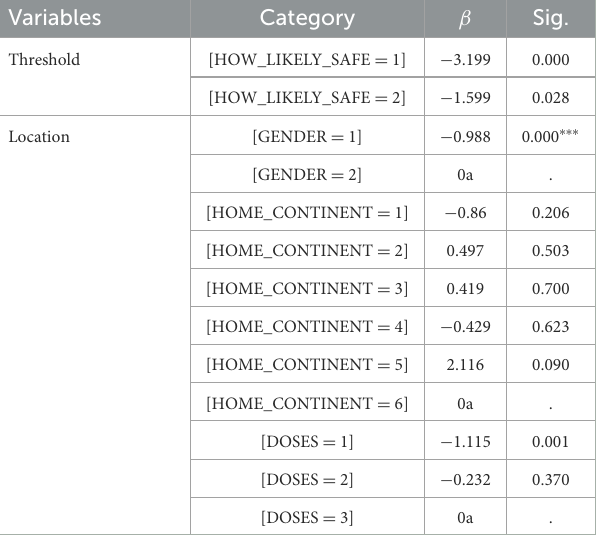
TABLE 4 Selected variables in logistic